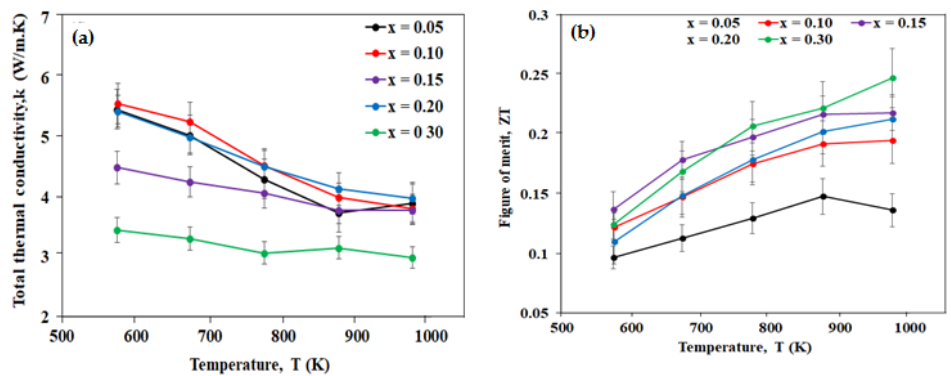
Figure 6. Temperature dependence of ( a ) total thermal conductivity, k , and ( b ) thermoelectric figure of merit, ZT, for VSTO-A ceramics.